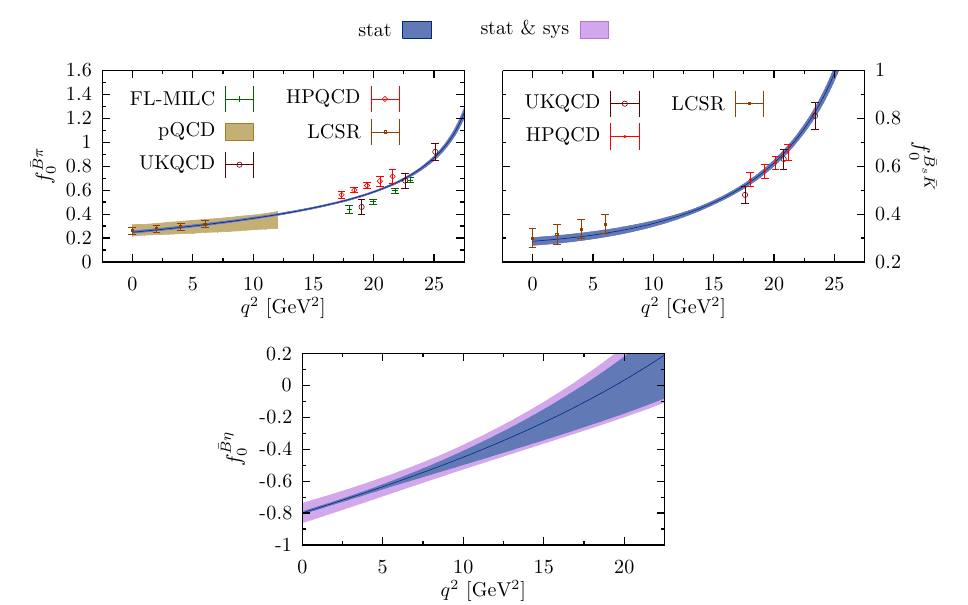
Fig. 12 Same as Fig. 8, but using a quadratic MO polynomial (see Eq. (B1)), and parameters given in Table 6 Table 6 Results from the fit to the scalar ¯ B → π and ¯ B s → K LQCD & LCSR form factors using rank-two MO polynomials (see Eq. (B1)), and with χ 2 defined in Eq. (49). There is a total of 22 degrees of free-